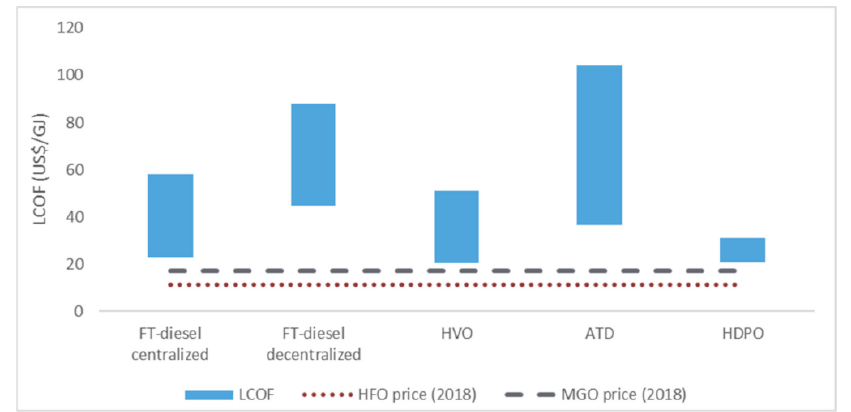
Figure 19. LCOF ranges (minimum and maximum values) for different technologies compared to average bunker fuel prices.